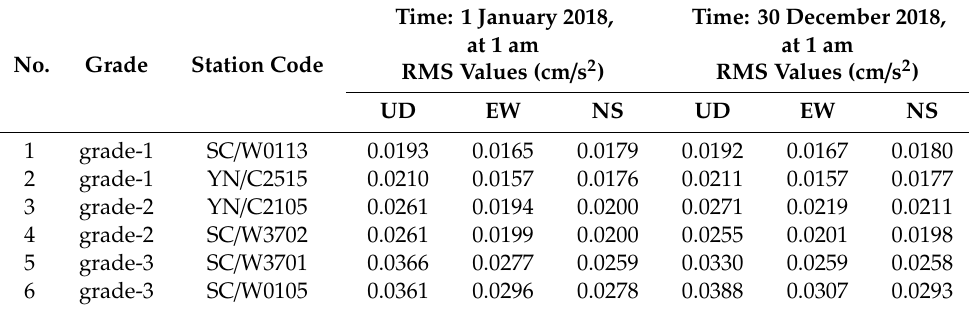
Table 2. RMS values for some GL-P2B